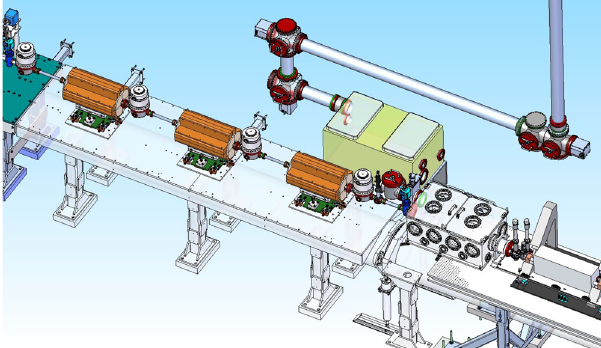
FIG. 10. Final focus triplet including a differential pumping system and experimental area laser